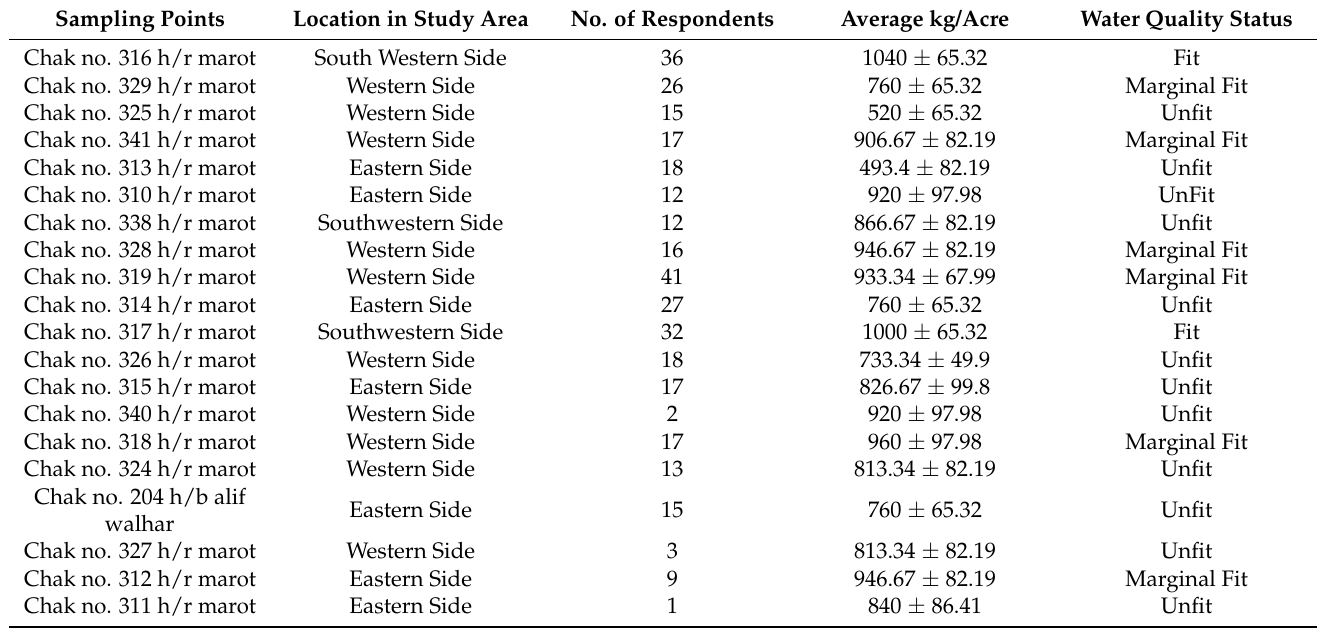
Table 3. Average cotton yield with respect to investigated area.